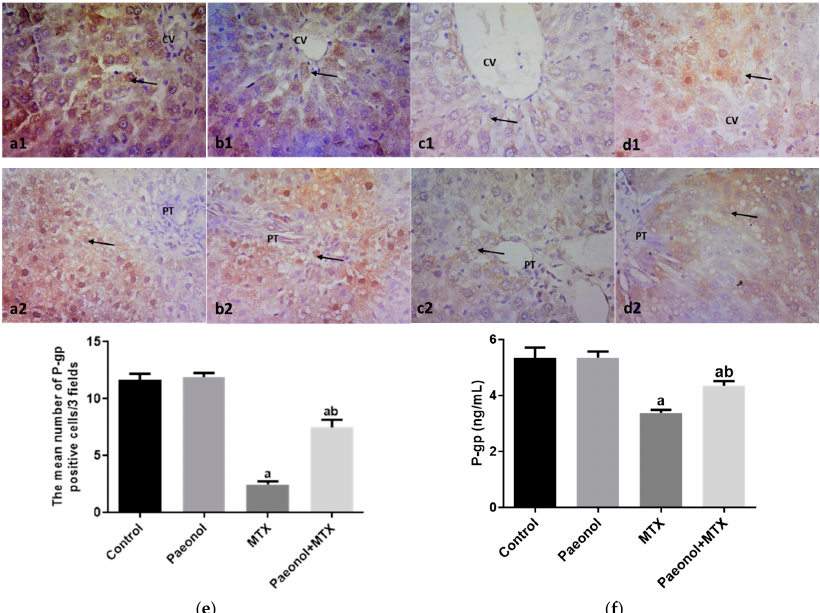
Figure 7. The immunohistochemical examination of hepatic P-glycoprotein (P-gp) expression in methotrexate (MTX)-induced hepatotoxicity ( × 400). The liver tissues of the control ( a1 , a2 ) and paeonol ( b1 , b2 ) groups show nuclear P-gp expression (arrows) in hepatocytes surrounding the central veins (CV) and portal areas (PT). The liver tissues of the MTX-treated rats show few nuclear P-gp expressions (arrows) ( c1 , c2 ). On the contrary, the liver tissues of the paeonol + MTX group show many nuclear P-gp expressions (arrows) in hepatocytes surrounding the CV and PT ( d1 , d2 ). A ( f ) semi-quantitative analysis of P-gp positive cells ( e ). Hepatic P-gp level using P-gp ELISA kit ( f ). Data are represented as mean ± SEM ( n = 6). Letters a,b Denote significant differences from the normal control and the MTX groups, respectively, at p <